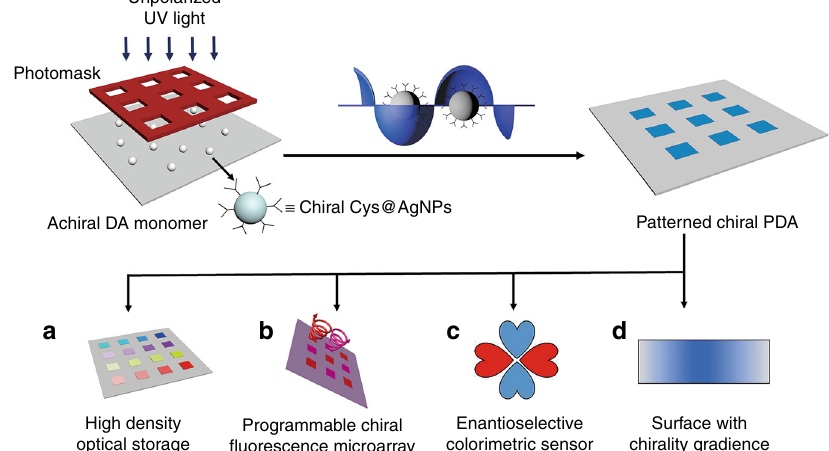
Fig. 1 Schematic of photopatterning of chirality in PDA fi lms and their potential applications. Highly asymmetric chiroptical PDA is obtained through enantioselective photo-polymerization assisted with noble metal nanoparticles. Arbitrary 2D patterns and/or distributions of PDA with tailorable chirality can be readily produced by controlling spacial distribution of UV irradiation. Various chiral PDA patterns could be fabricated as designed, such as a a microarray of chiral PDA, b a display panel with chiral fl uorescence, c a clover-shaped pattern as an enantioselective sensor, and d a gradient of